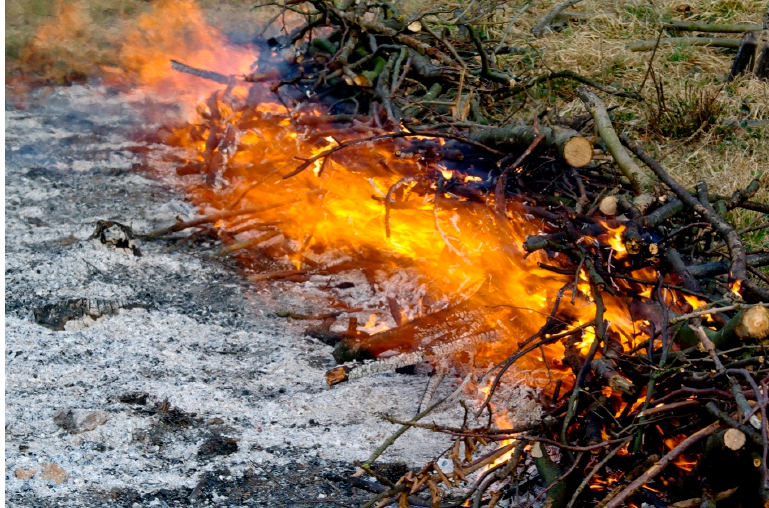
Figure 3. Burning by pulling burning wood cylinders, made of branches and twigs, over the ground (speed ca. 3 m·h − 1 ).